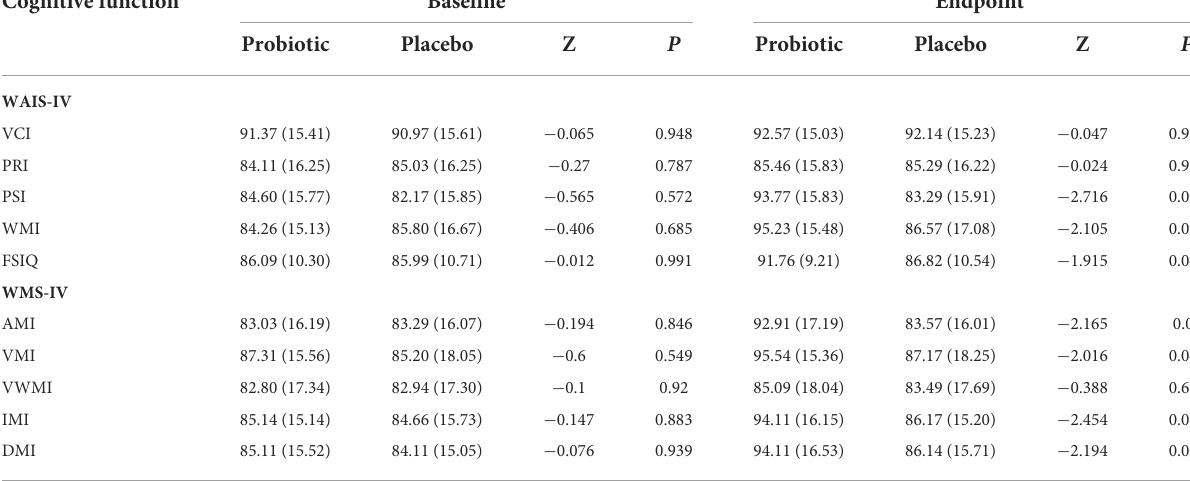
TABLE 2 Comparison between groups on WAIS-IV and WMS-IV.